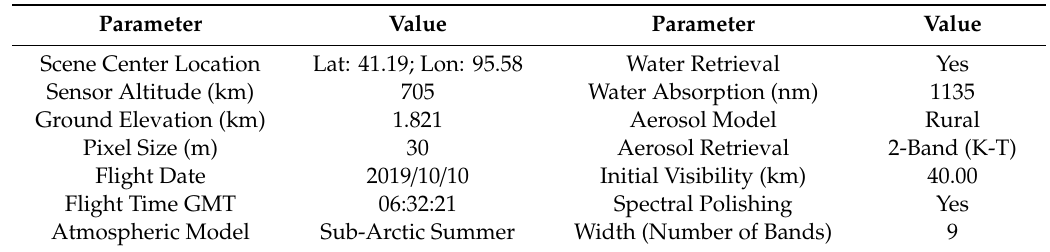
Table 4. Main parameters of fast line-of-sight atmospheric analysis of spectral hypercubes (FLAASH) atmospheric